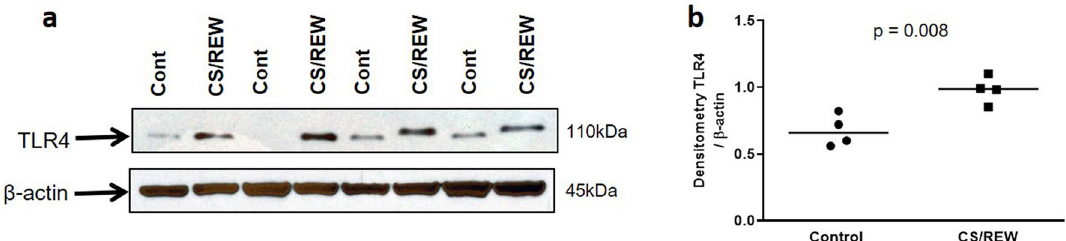
Figure 1. Immunoblot and densitometry for tubular toll like receptor 4 (TLR4) in-vitro: ( a , b ) Cells subjected to cold storage followed by rewarming (CS/REW) had significantly increased expression of TLR4 compared to the control cells which were kept at 37 °C (0.980 ± 0.051 vs. 0.675 ± 0.059; ** p < 0.01 vs. Control). Immunoblots from three separate experiments were identical to the representative picture. β-actin is used as a